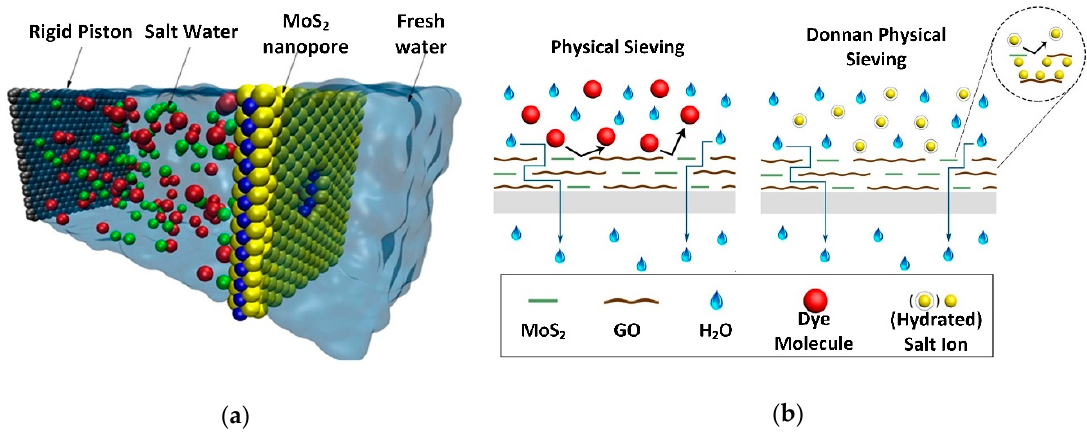
Figure 7. ( a ) Single-layer MoS 2 water desalination membrane with Mo only pores (Reproduced with permission from [193]. Copyright 2015 Springer Nature Limited CC BY 4.0). ( b ) MoS 2 / GO nanosheets intercalated membrane for removal of dyes and salts (Reproduced with permission from [196]. Copyright 2020 Elsevier